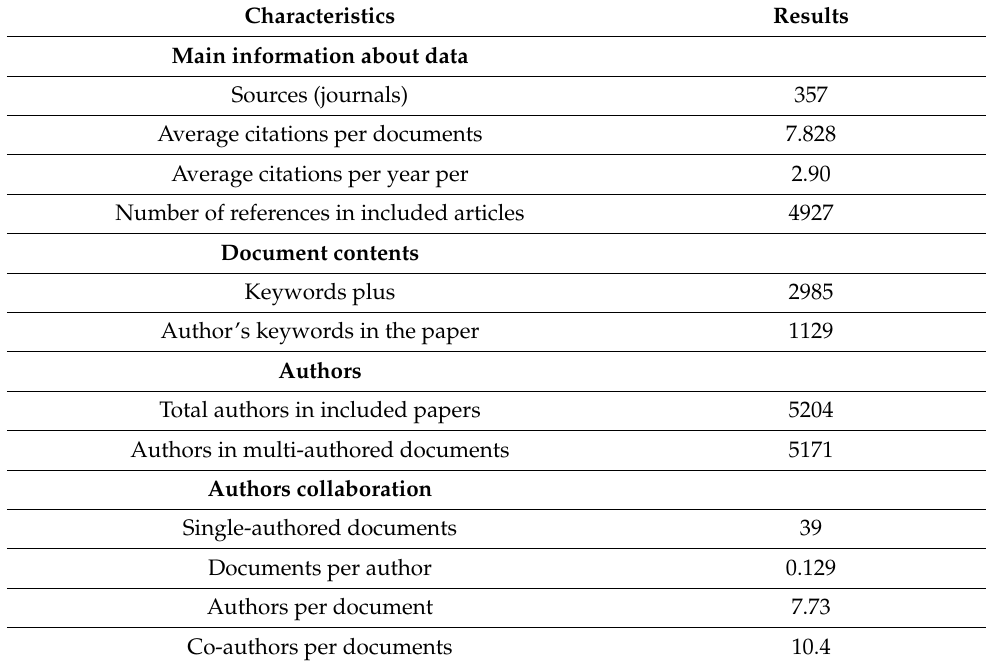
Table 1. Characteristics of included articles (N =